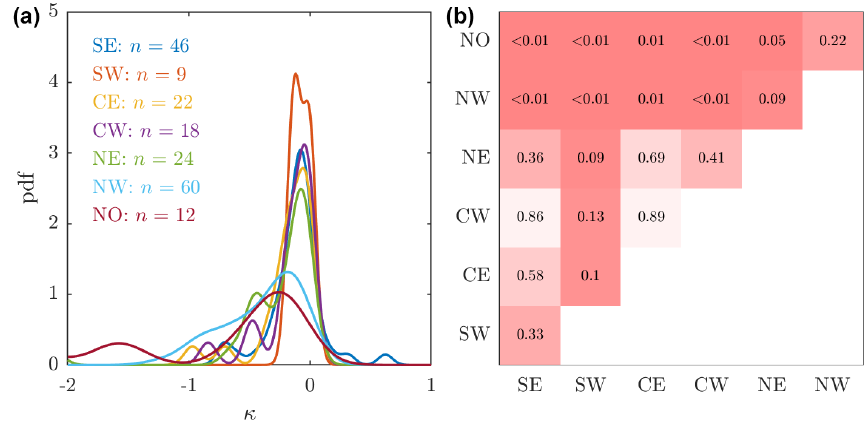
Figure 6. Sector-to-sector differences in sensitivity of glaciers to submarine melting. (a) Equivalent of Fig. 5a by ice sheet sector, where n indicates the number of glaciers entering the probability density function. (b) The p value obtained from a two-sample Kolmogorov–Smirnov test to determine significance of differences between sectors. A value p < 0 . 05 indicates a significant difference between sector distributions in (a) and thus a significant difference in sector sensitivity to submarine melting.